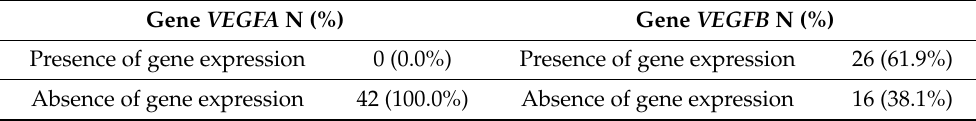
Table 2. The results for the VEGFA and VEGFB gene expression in the studied groups of samples. Gene VEGFA N (%) Gene VEGFB N (%) Presence of gene expression 0 (0.0%) Presence of gene expression 26 (61.9%) Absence of gene expression 42